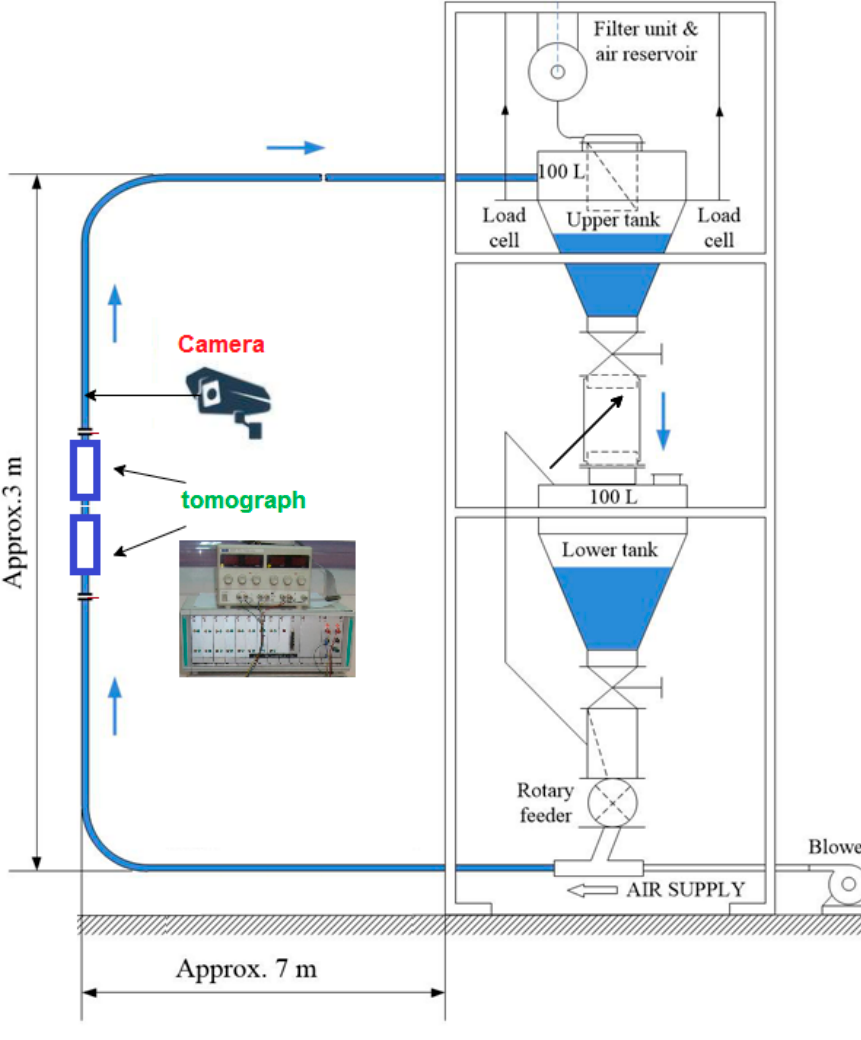
Figure 6. Pneumatic material conveying system schema with tomography sensors and video cam- era placement.